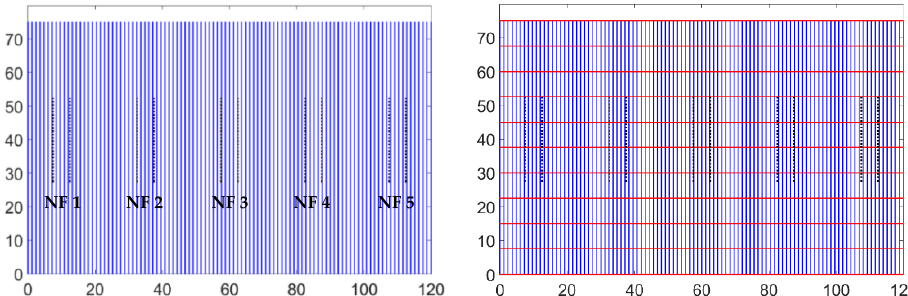
Figure 3. Base case model for homogenous reservoir space with five discrete natural fracture elements all having equal porosity and permeability. Left: Streamlines (blue) for uniform flow from bottom to top through reservoir space and natural fractures (dashed black). Right: Time-of-flight (TOF) contours (red) shown every 3 years during a total simulated time of 30 years.